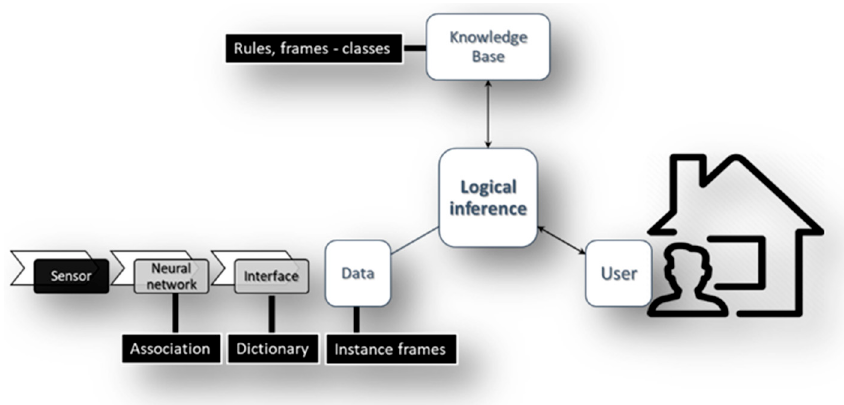
Figure 3. Levels of information processing.